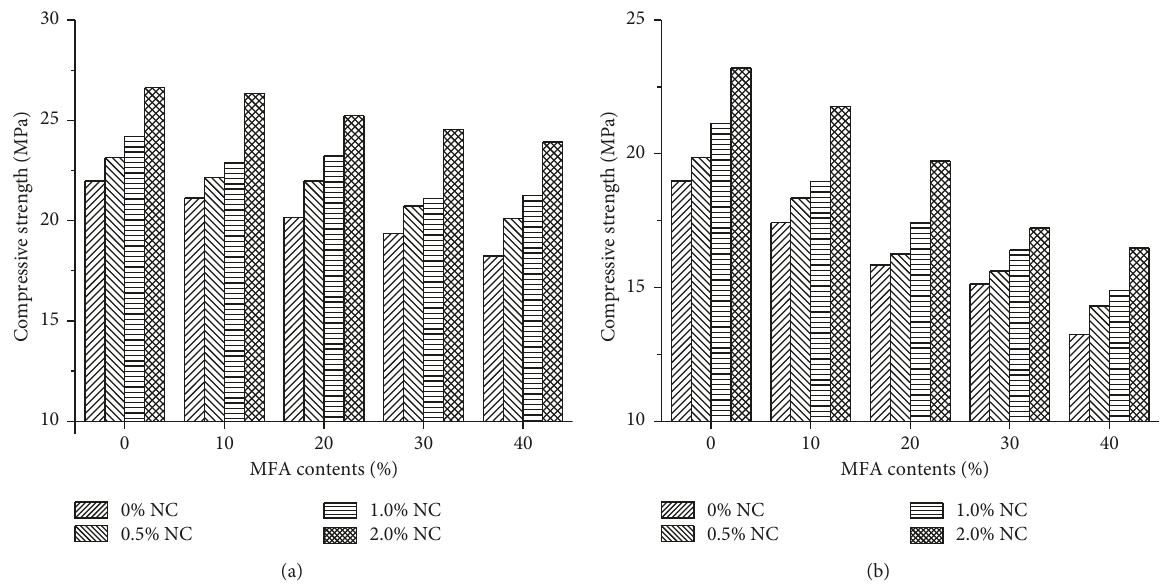
Figure 10: 28-day compressive strength of hardened grouts with a W/S ratio of 1.2: (a) 0% SP; (b) 1.5%